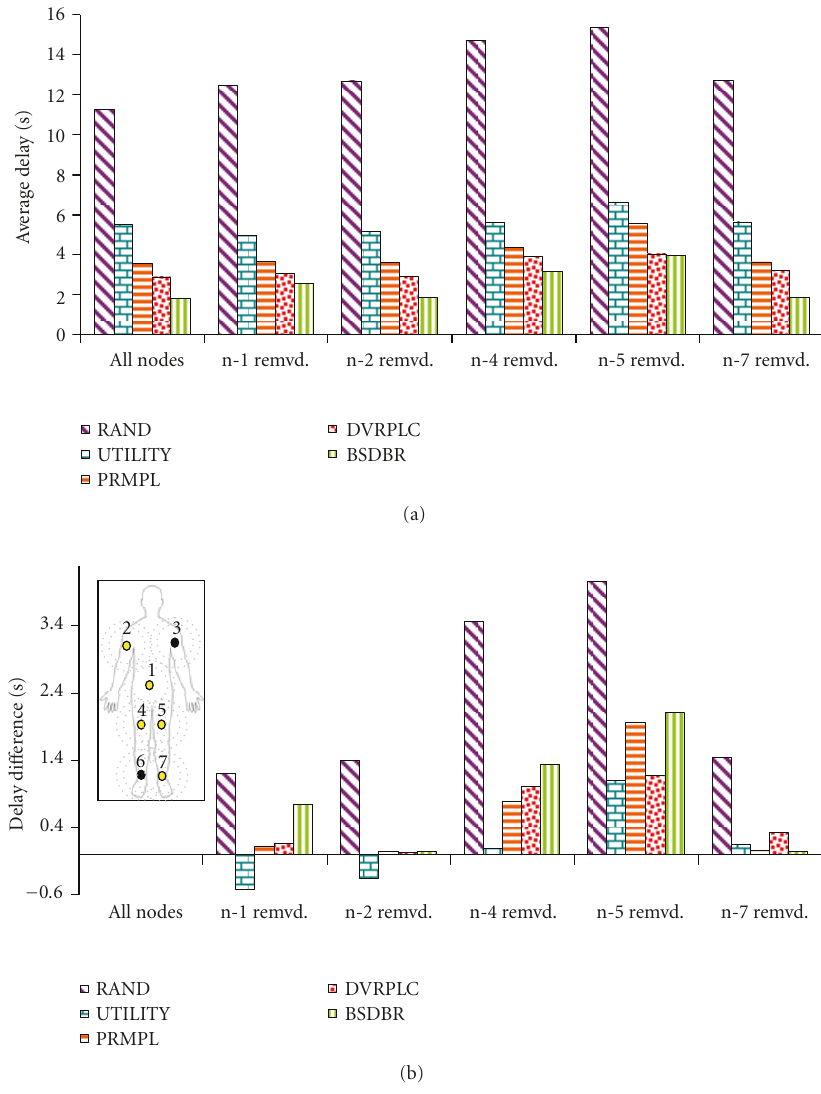
Figure 16: Single node criticality in terms of (a) packet delay and (b) packet delay di ff